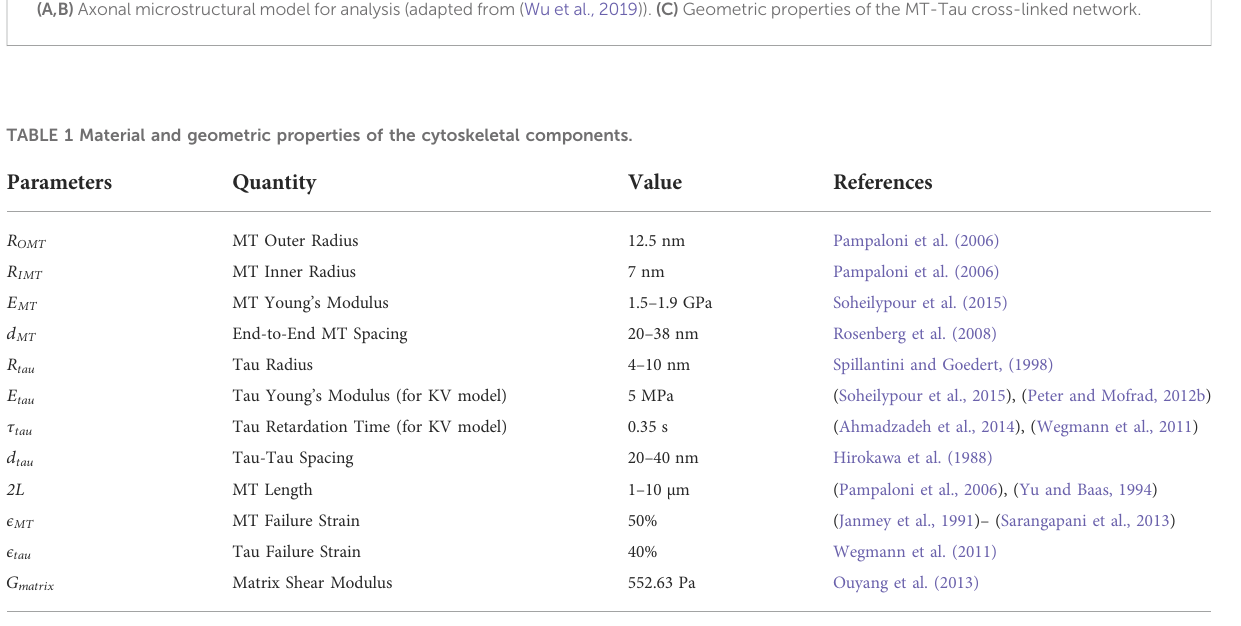
FIGURE 2 (A,B) Axonal microstructural model for analysis (adapted from (Wu et al., 2019)). (C) Geometric properties of the MT-Tau cross-linked network.